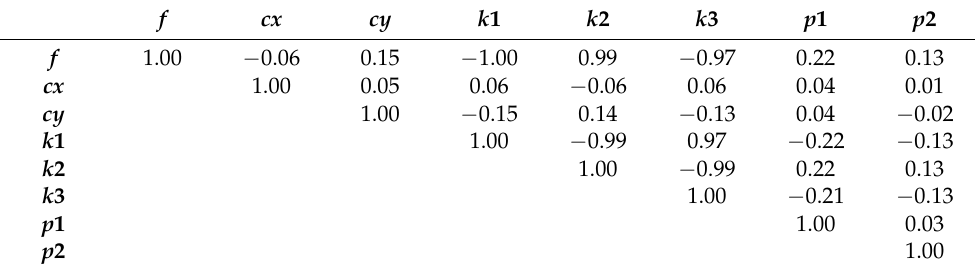
Table 3. Dependencies of the parameters of interior orientation after self-calibration.